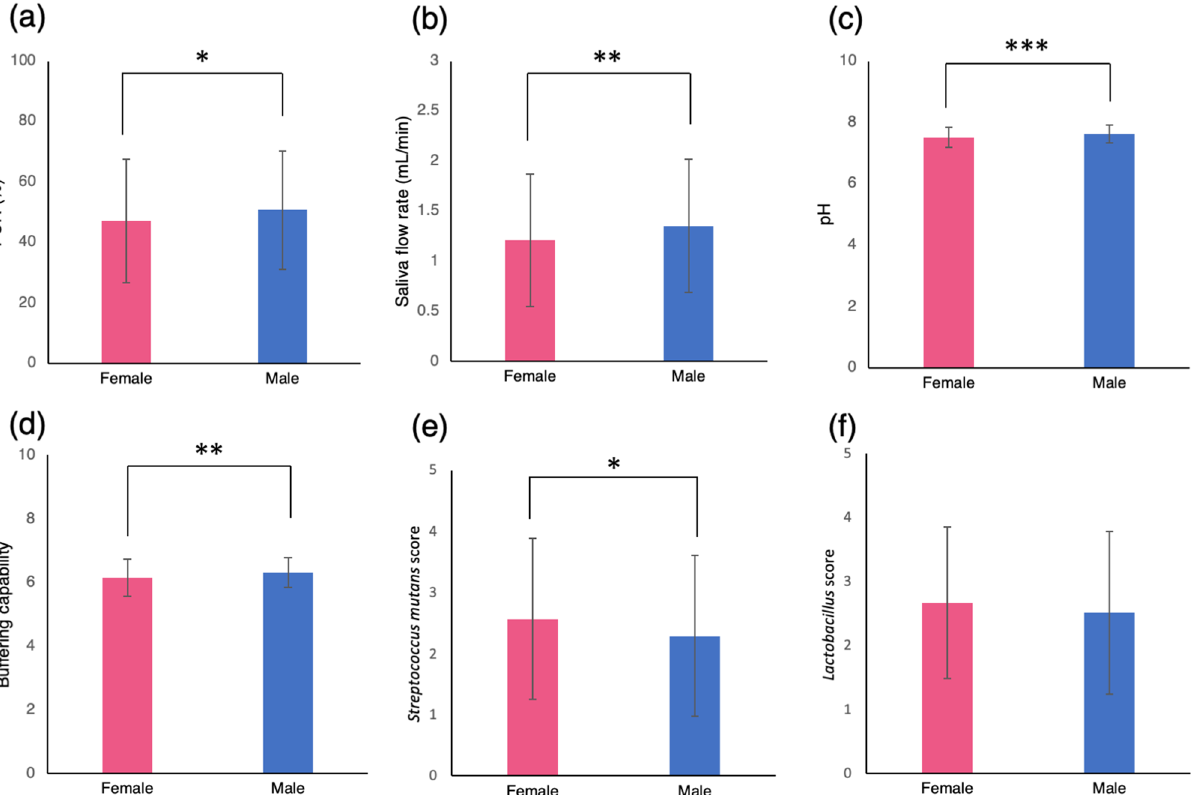
Figure 1. Comparison between females and males. Comparison of the average scores of ( a ) PCR, ( b ) Saliva flow rate, ( c ) pH, ( d ) Buffering capability, ( e ) Streptococcus mutans score, and ( f ) Lactobacillus spp. score between females (n = 387) and males (n = 232) using the Mann–Whitney U test. Significant differences are indicated as * p < 0.05, ** p < 0.01 and *** p < 0.001. PCR, plaque control